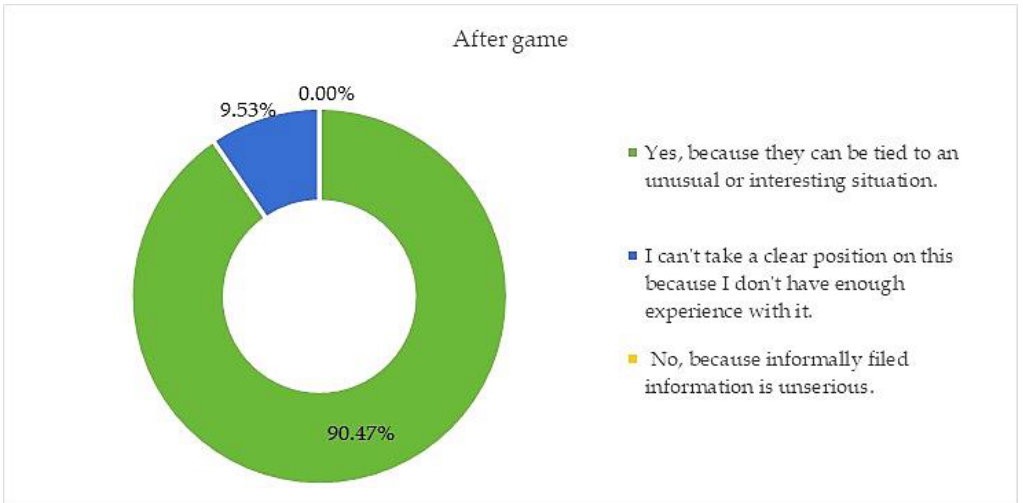
Figure 7. Results of questionnaire for question: Can information given in an informal way be more lasting than formal ones? (before using toolkit).